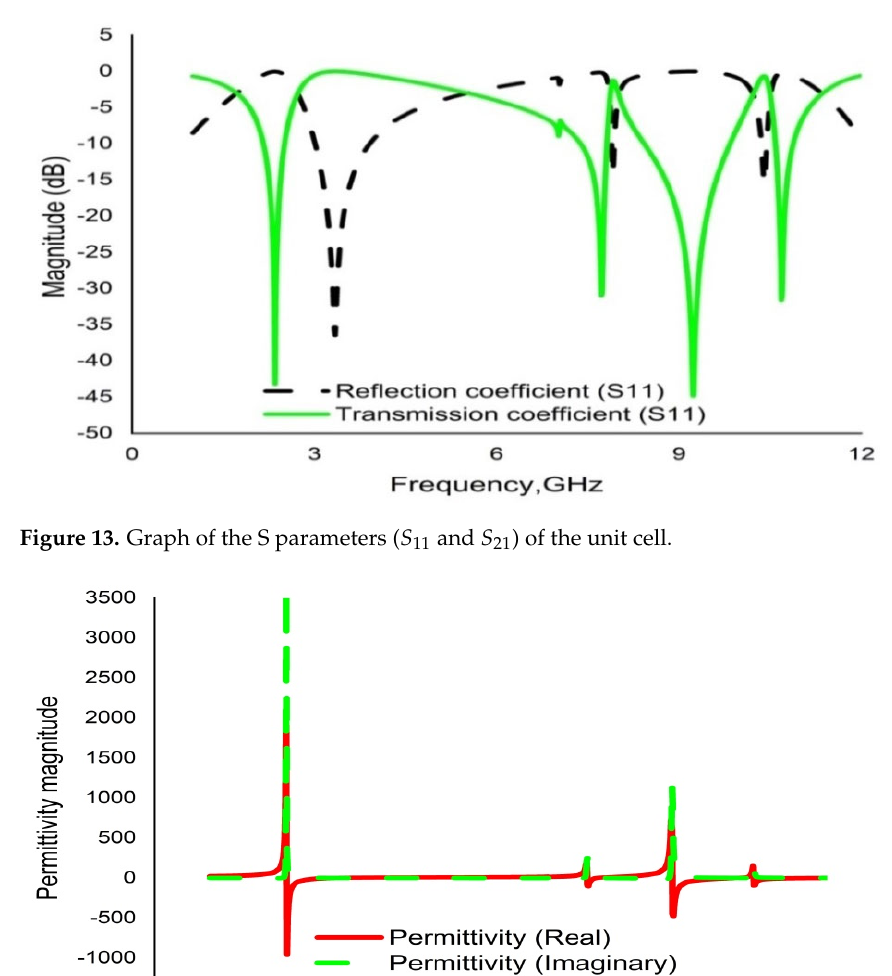
Figure 14. Graph of real and imaginary magnitudes of permittivity ( ℇ ) for the unit cell.